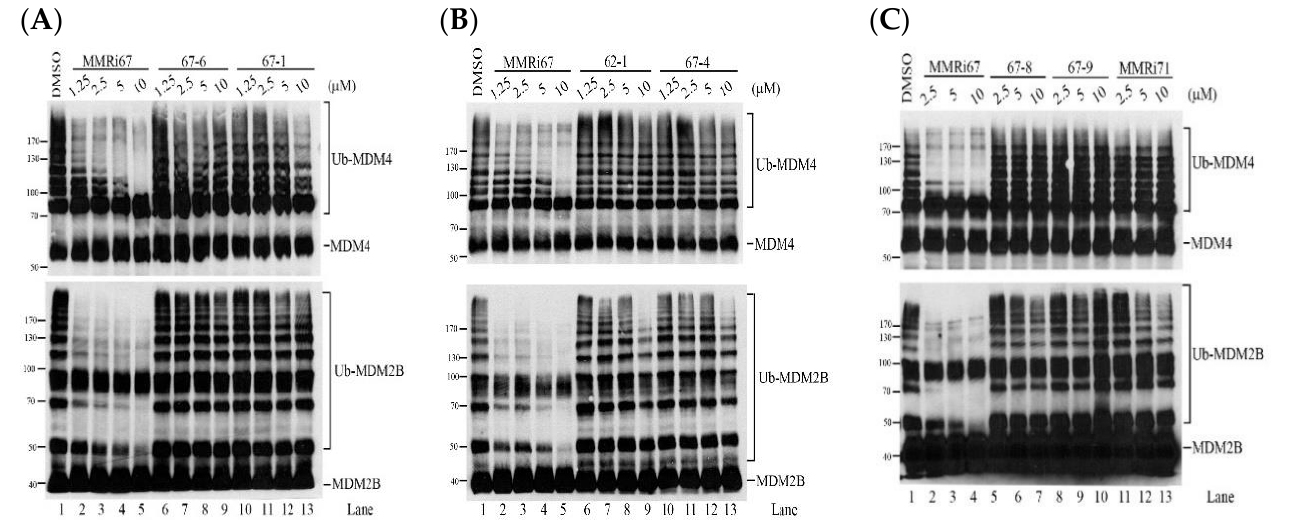
Figure 3. Assessment of the inhibitory effect of MMRi67 derivatives toward MDM2B-MDM4 E3 ligase in the in vitro E3 ligase assays. ( A ) Comparison of MMRi67 with hydroxyl to hydrogen substituted ( 67-6 ) and chloro to hydrogen substituted ( 67-1 ) analogs in inhibition of the MDM4 and MDM2B ubiquitination in vitro. WB analysis of MDM4 or MDM2B using specific antibodies after in vitro ubiquitination reaction in the presence of a solvent or indicated compound at the indicated concentrations. The smearing bands of ubiquitinated MDM4 (Ub-MDM4) and MDM2B (Ub-MDM2B) are indicated. ( B ) Same analysis as in ( A ) except for the comparison of MMRi67 with carboxylic acid substituted analogs 62-1 and 67-4 in the inhibition of MDM4 and MDM2B ubiquitination in vitro. ( C ) Same analysis as in ( A ) except for the comparison of MMRi67 with pyridine substituted analogs 67-8 and pyridine, hydroxyl, and carboxylic acid substituted analogs 67-9 and MMRi71 in the inhibition of MDM4 and MDM2B ubiquitination in